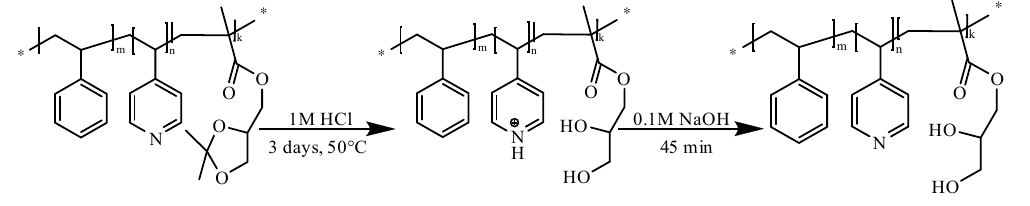
Figure 5. The deprotection reaction of the ketal-PSMA moiety.